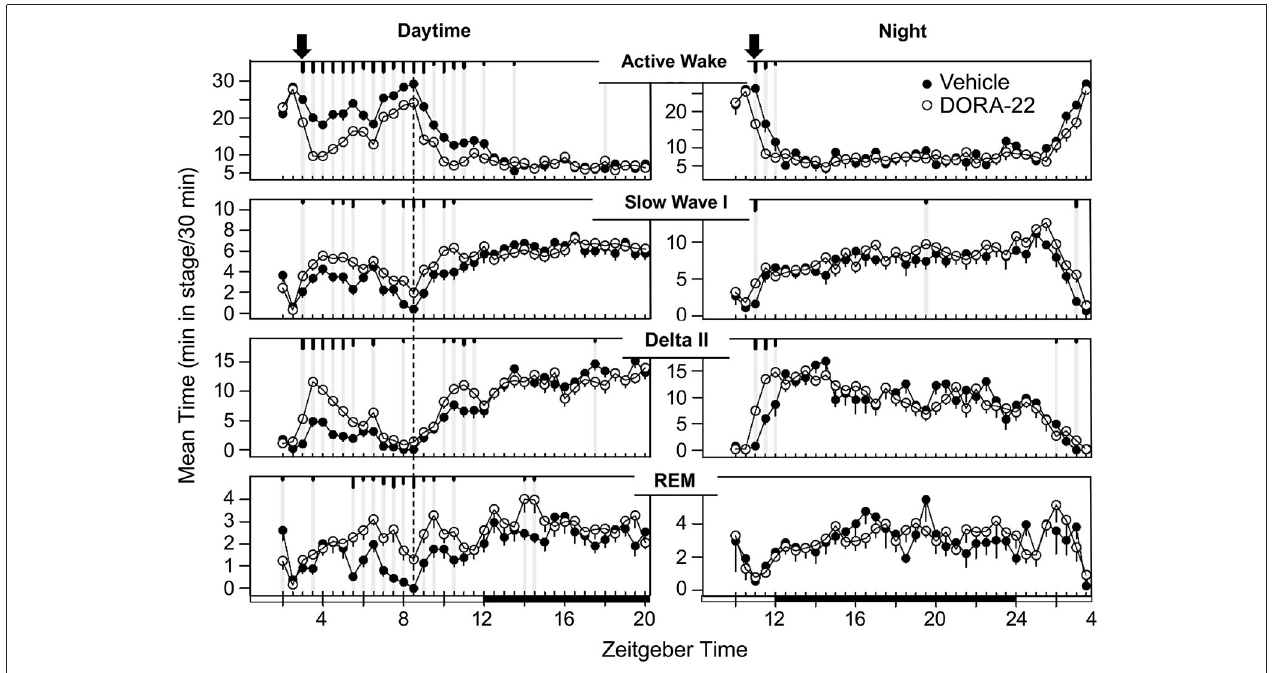
Data are presented as mean per dog over 5 days of consecutive treatment per 30-min epoch ± SEM. Arrows, dosing; dashed line, feeding (daytime); gray vertical lines and tic marks (short, medium, long: p < 0.05; p < 0.01; p < 0.001, respectively).